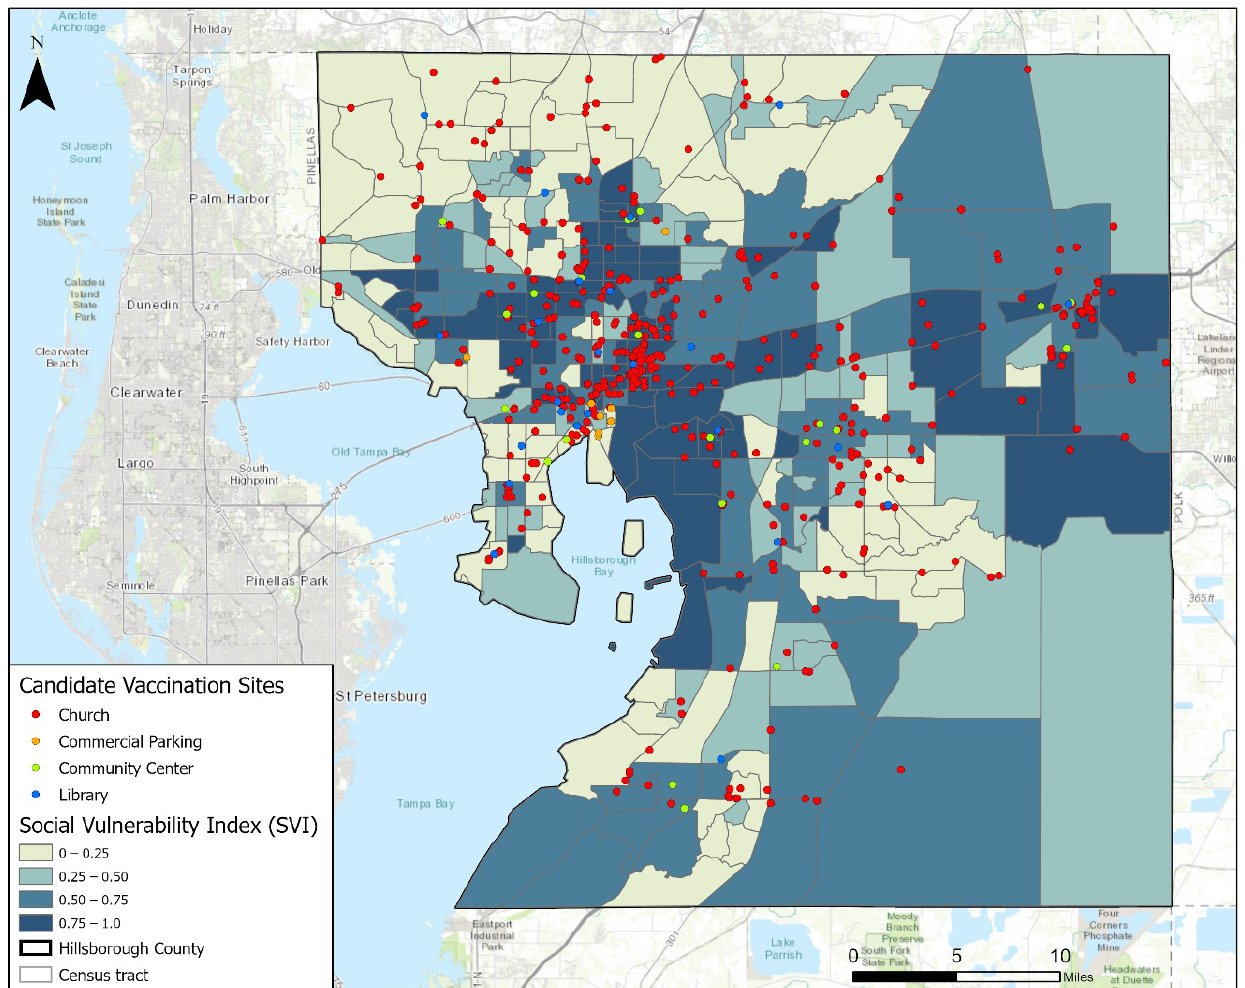
Figure 2. Candidate vaccination sites in Hillsborough County, Florida.